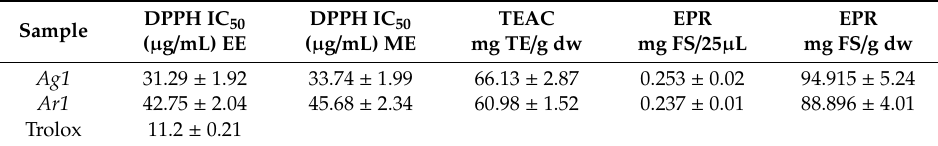
Table 5. DPPH, TEAC, EPR activity of A. genevensis ( Ag1 ) and A. reptans ( Ar1 ) (mean ±